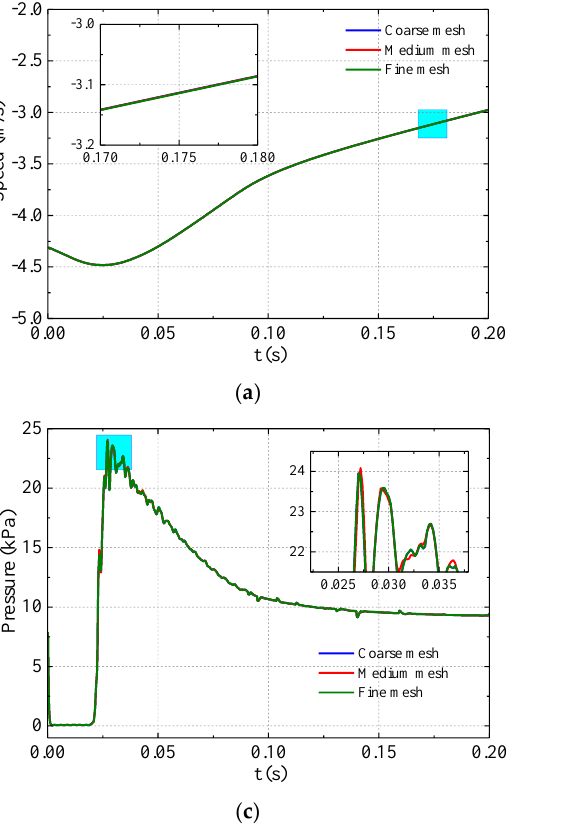
Figure 11. Comparison of time series of slamming results by different FE grid schemes: ( a ) vertical speed; ( b ) vertical total force; ( c ) pressure at P1; ( d ) structural stress at S2.